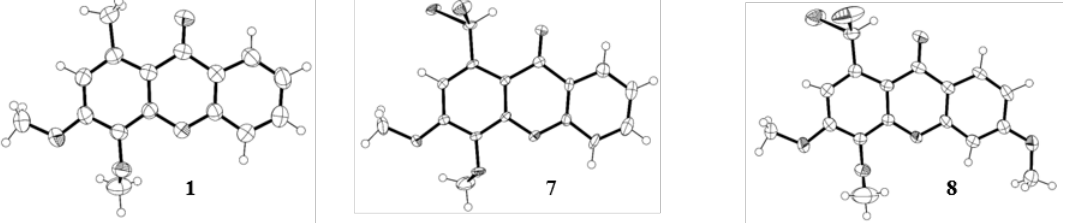
Figure 3. Ortep view [25] of the crystal structure of 1-methyl-3,4-dimethoxy-9 H -xanthen-9-one ( 1 ), 1-(dibromomethyl)-3,4-dimethoxy-9 H -xanthen-9-one ( 7 ) and 1-(dibromomethyl)-3,4,6-trimethoxy-9 H -xanthen-9-one ( 8 ).